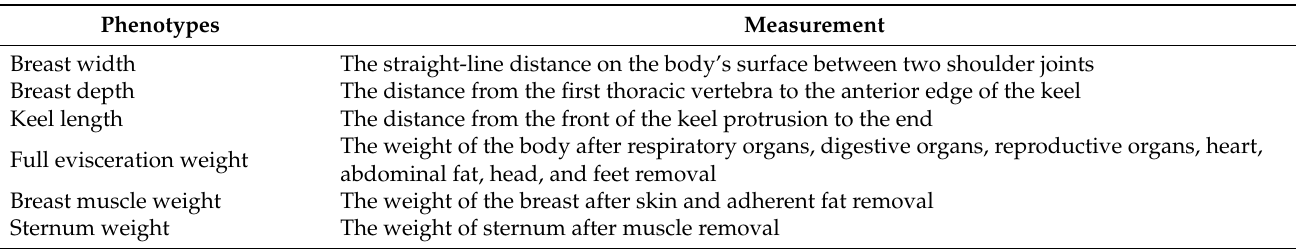
Table 2. The phenotypes and measurement